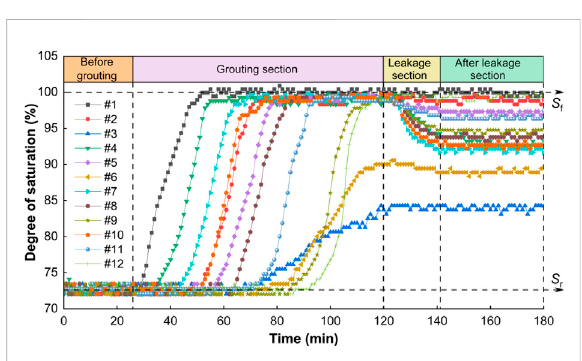
FIGURE 10 Degree of saturation for #1 – 12 vs. time. Here, S r indicates initial saturation and S f indicates complete